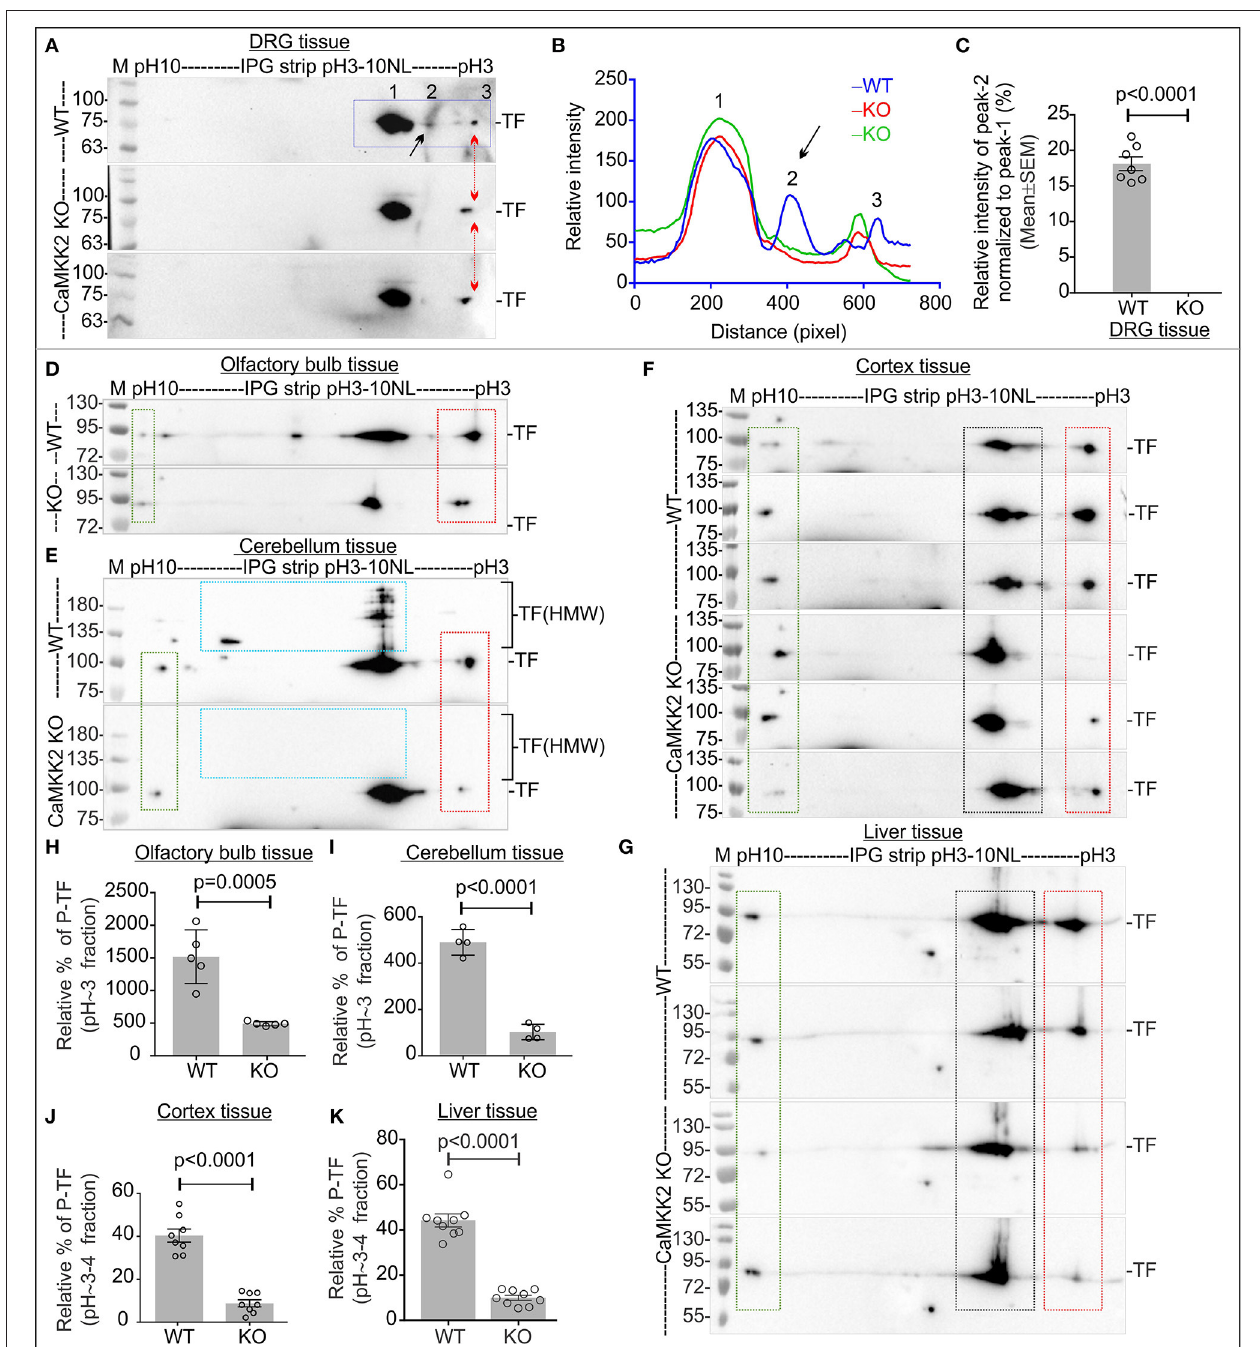
FIGURE 6 | P-TF was ubiquitously and significantly reduced in the CaMKK2 KO mice. (A,D–G) Immunoblots showing charged fractions of TF. Rectangle areas represent charged fraction of TF at different pH/pIs. The red arrow/red square indicates altered P-TF (pH ∼ 3-4 fractions). The green rectangle area represents TF fraction which was used to normalize the intensity of the pH ∼ 3-4 fractions in the red square area. (B) Intensity profile of the focused spots presented in the immunoblots in (A) , blue squared area. The spots are marked with Arabic numerals and spot 2 was quantified. (C) Scatter plot showing the relative intensity of spot 2 in pH ∼ 3-4 fractions of TF. N = 7 replicates from 3 mice in each category. The p -value by t -test (unpaired). (H–K) Scatter plot showing the relative amount of P-TF (pH ∼ -4 fractions) in olfactory bulb, cerebellum, cortex and liver tissues, respectively. N = 5/4/7/8 replicates from 3 to 4 KO and wild-type mice, respectively. The p -value by t -test